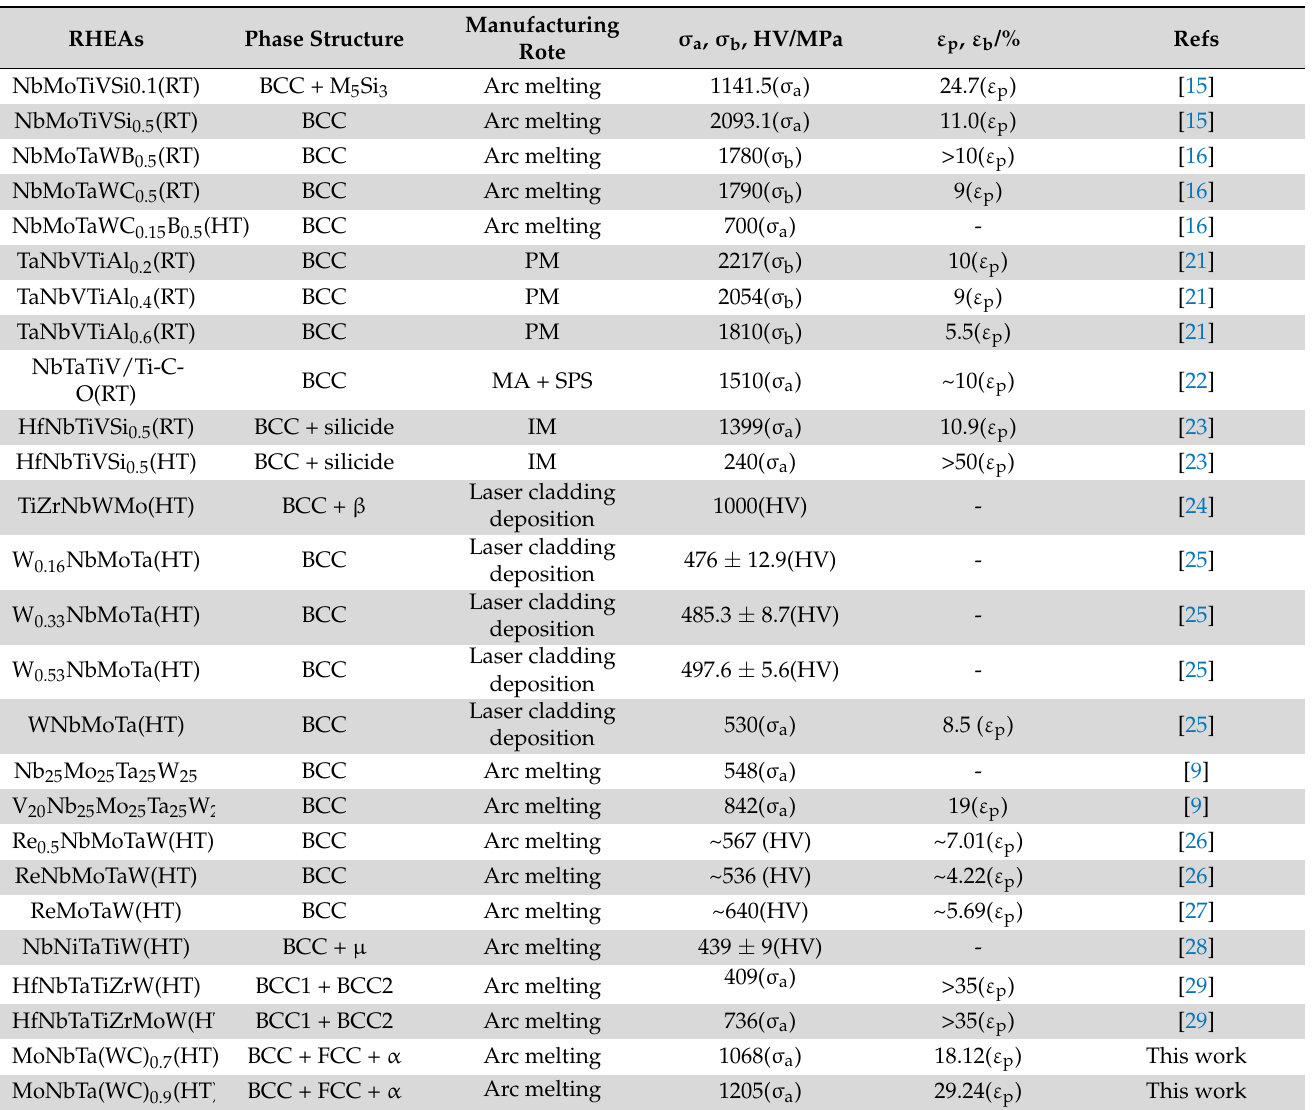
Table 1. Yield strengths ( σ a ), fracture strength ( σ b ), hardness (HV), plastic strain ( ε p ), and fracture strain ( ε b ) of HEAs at